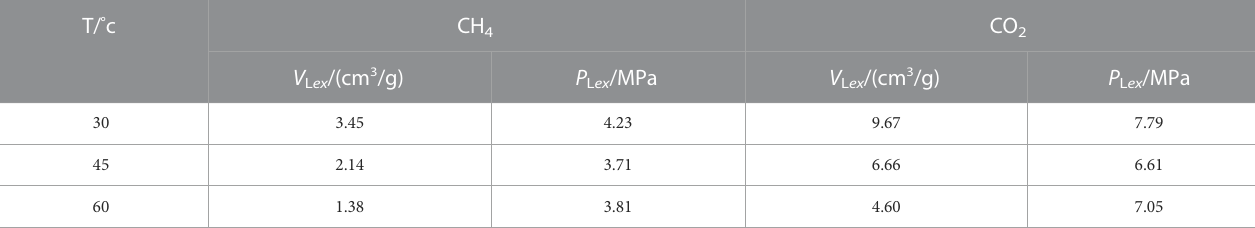
TABLE 1 The fi tting parameters of Langmuir equation.